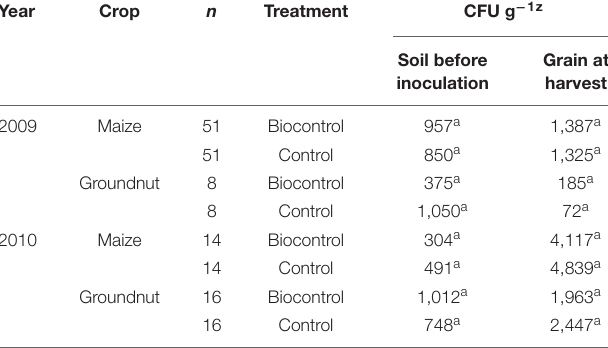
TABLE 2 | Colony-forming units (CFU) g − 1 of Aspergillus section Flavi fungi in soil before biocontrol application and in maize and groundnut grains harvested from farmers’ fields that were either treated or not treated during 2009 and